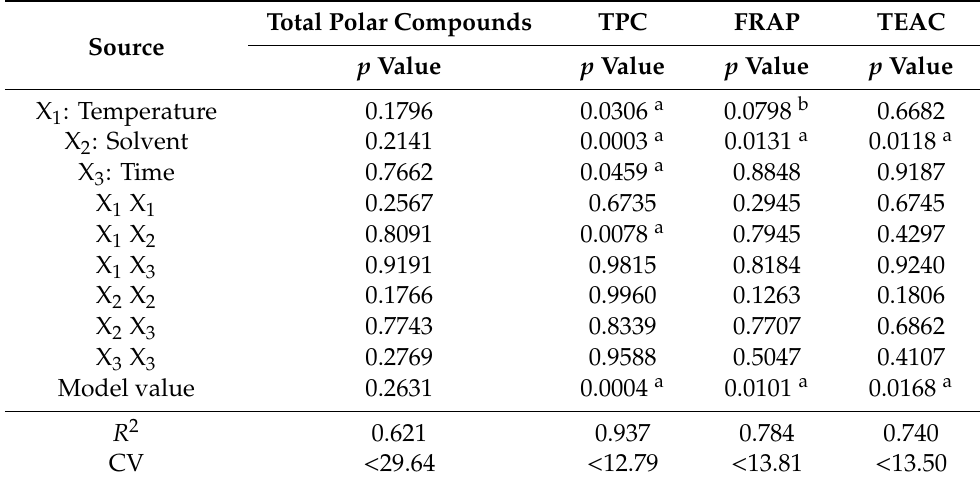
Table 5. Analysis of variance (ANOVA) of the regression models in H. sabdari ff a . Response variables: Total Polar Compounds, TPC, FRAP and TEAC.